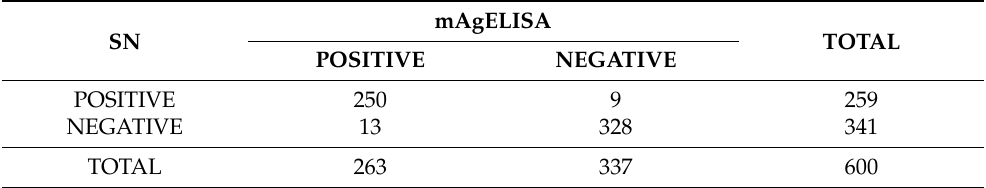
Table 4. Comparison between serum neutralization (SN) and mAgELISA in detecting antibodies to bovine and bubaline alphaherpesviruses in bovine sera (n = 600)